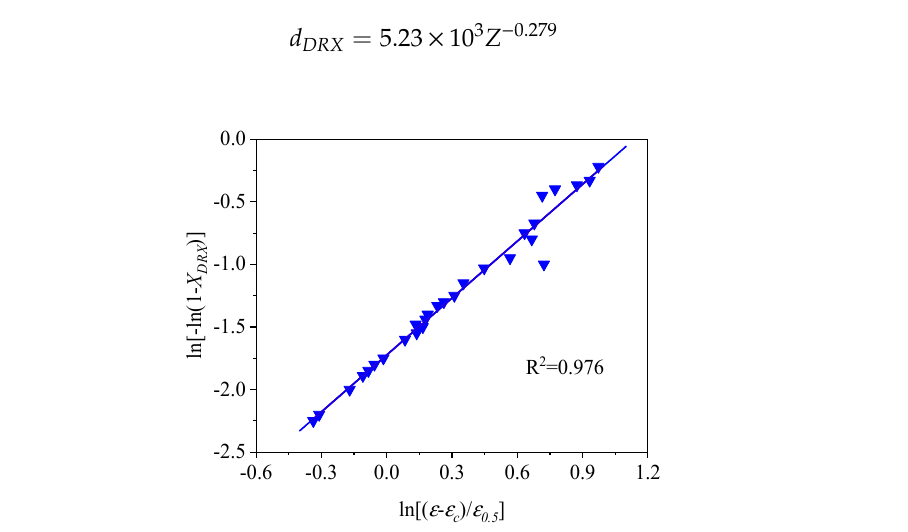
Figure 14. Relationship between ln [ − ln ( 1 − X DRX )] and ln [( ε − ε c ) / ε 0.5 ] .